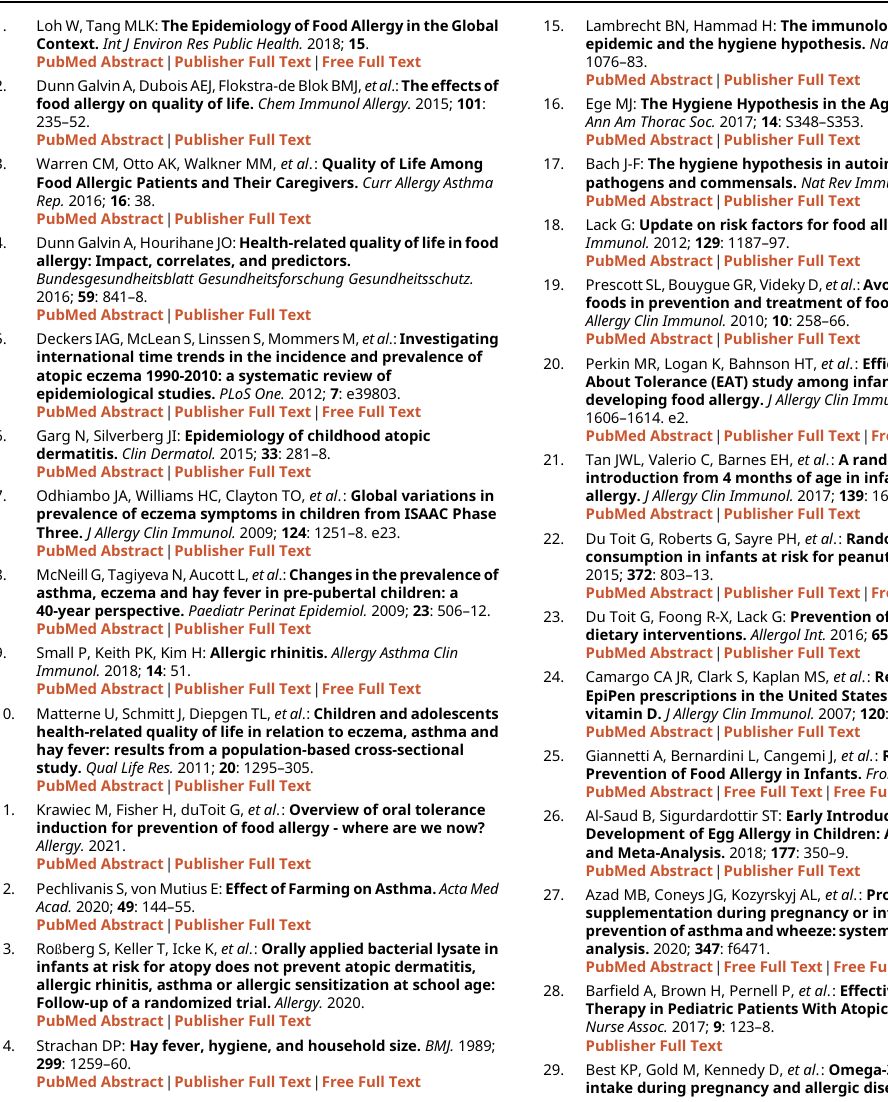
Figshare: PRISMA-P checklist for “ The evidence for interventions in early childhood allergy prevention – towards a living systematic review: protocol ” https://doi.org/10.6084/m9.figshare.14135450.v1. 95 Data are available under the terms of the Creative Commons Attribution 4.0 International license (CC-BY